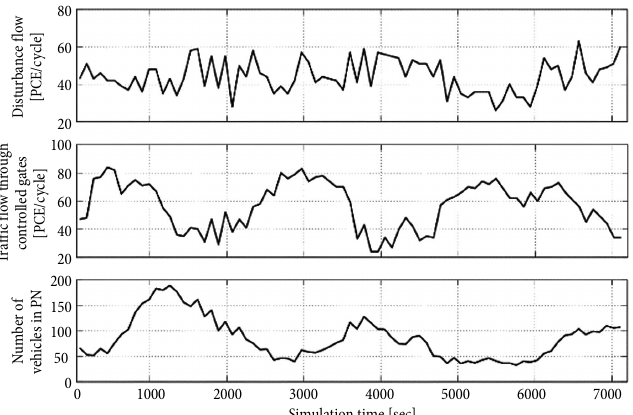
Fig. 8. Scenario 2: gate inputs and number of vehicles in PN